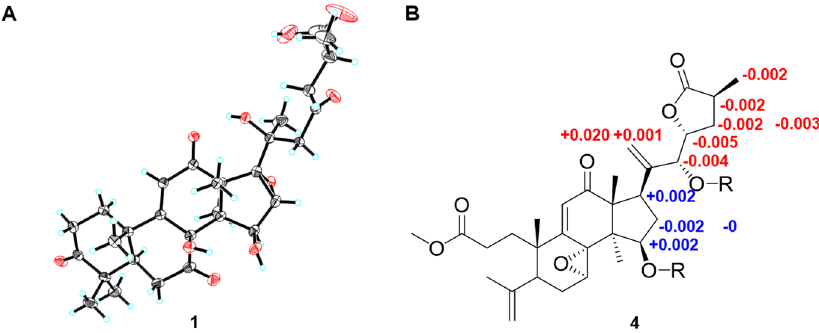
Figure 3. ( A ) X-ray crystallographic structure of 1 ; ( B ) values of δ S – δ R of the MTPA esters of 4